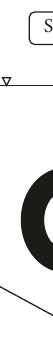
Figure 3: Schematic diagram of the pilot-scale